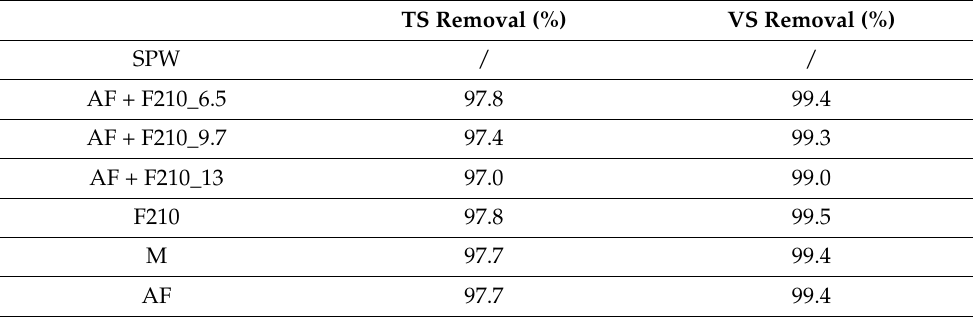
Table 3. Percentage of TS and VS removed at the end of the experiment. TS Removal